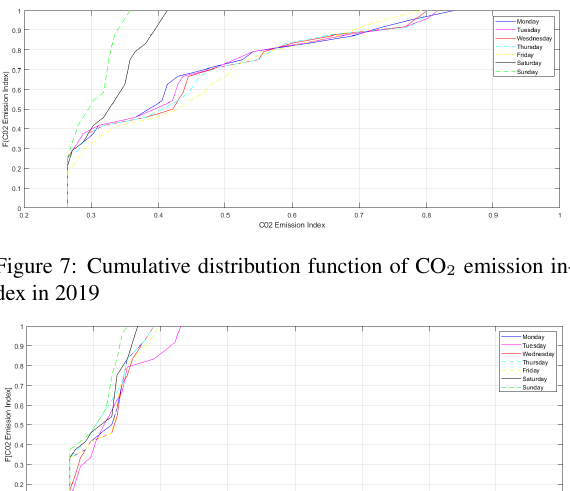
Figure 4: Time evolution of Congestion index during a lock-down week